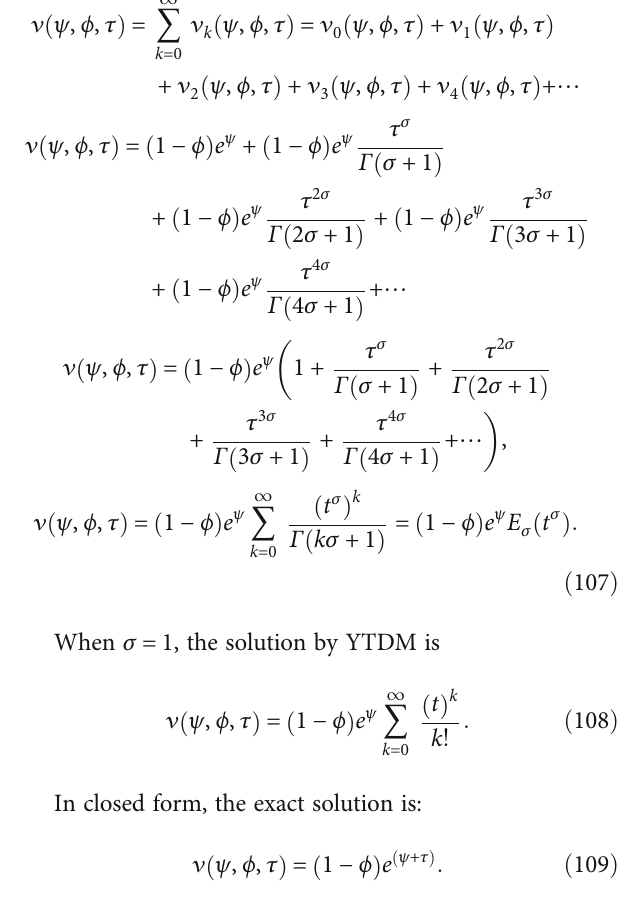
Figure 5(a) shows the error graph for di ff erent values of σ = 1,0 : 8,0 : 6,0 : 5 and 0 ≤ ψ , ϕ ≥ 1 of Example 3 and Figure 5(d) respectively, at ϕ = 0 : 5, τ ∈ ½ 0, 1 (cid:2) and 0 ≤ ψ ≥ 1 while Figure 5(e) shows the error graph. From the fi